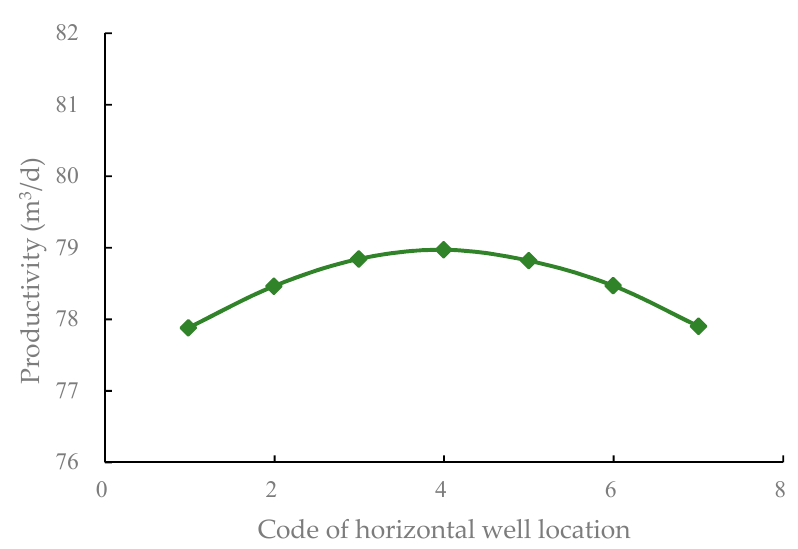
Figure 11. Productivity variation of horizontal well in mixed well pattern.